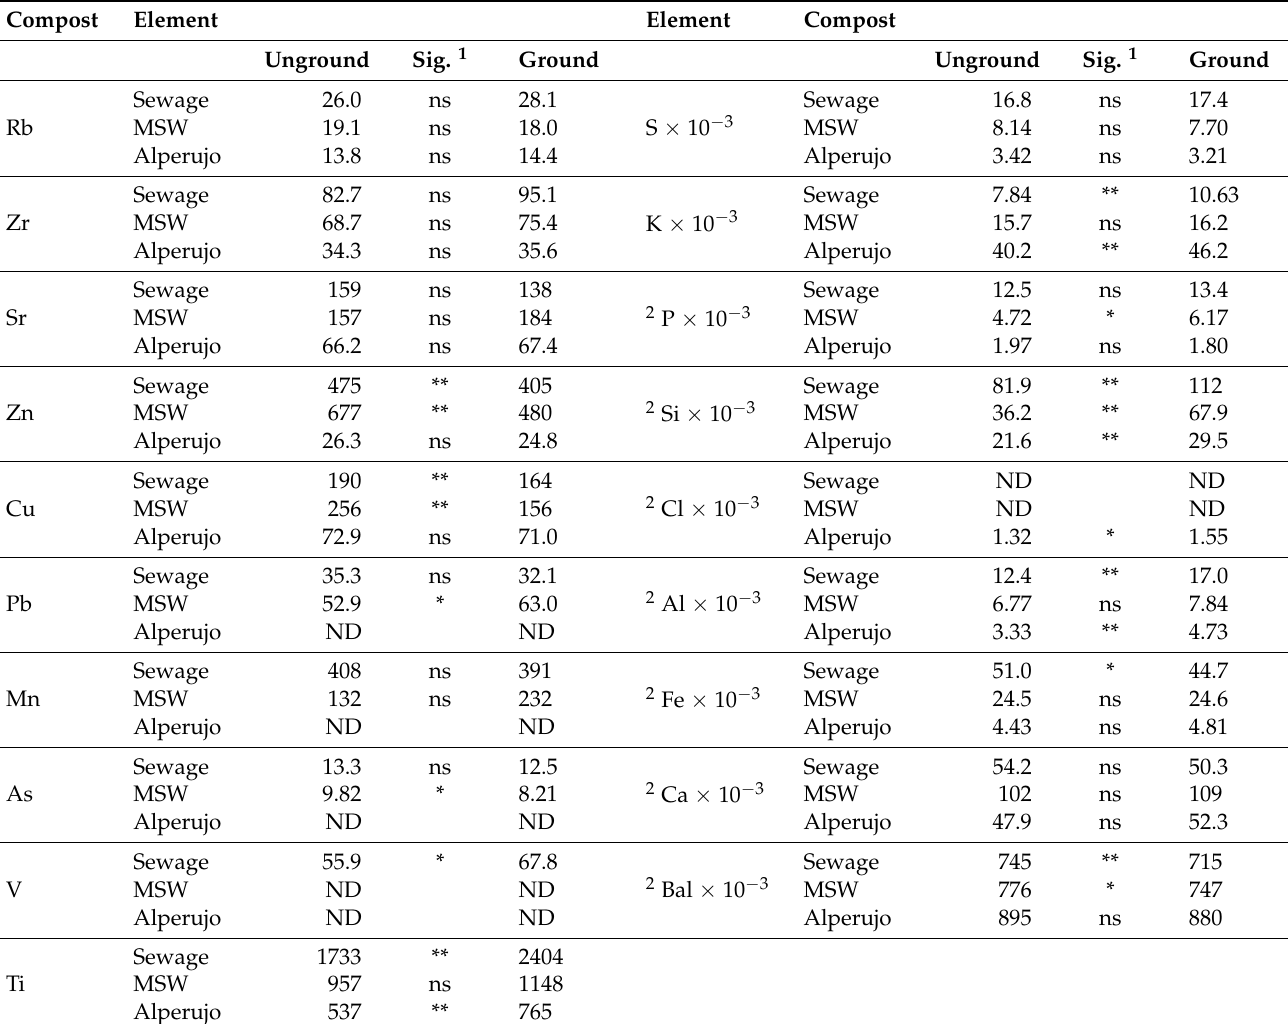
Table 5. Effect of grinding the coarser than 0.5 mm particle size fractions on the pXRF elemental readings (comparison by t -test in the paired replicates per each